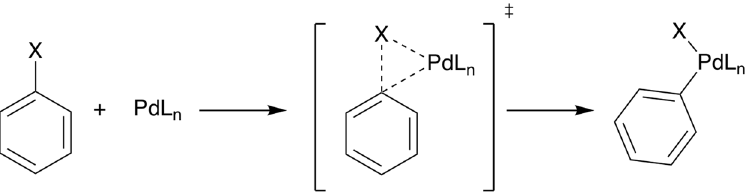
Figure 2. General representation of the arylic C–X bond activation by a palladium catalyst, where X = H, Cl or